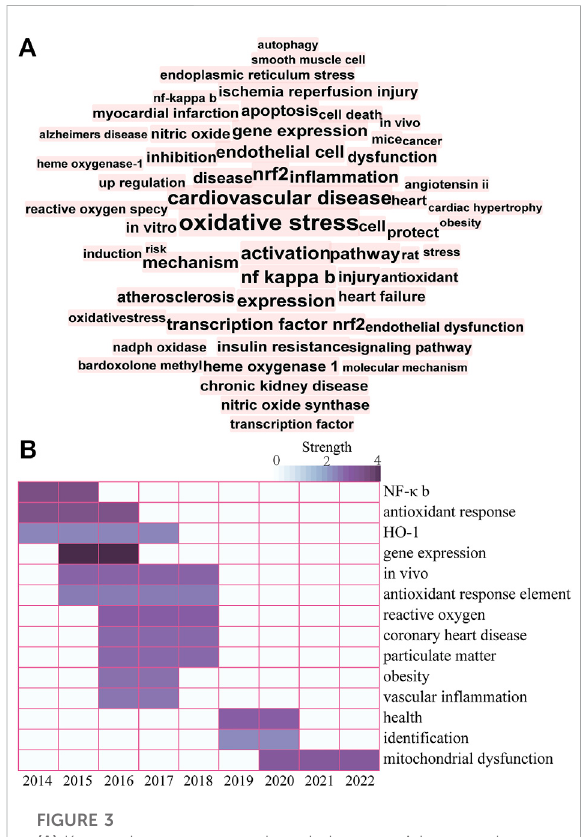
FIGURE 3 (A) Keyword co-occurrence knowledge map. A larger and more centered font corresponds to the number of times a keyword appears. (B) Top 14 keywords with the strongest citation bursts. The color depth represents the strength value of keywords with the strongest citation bursts. Darker color corresponds to a larger strength